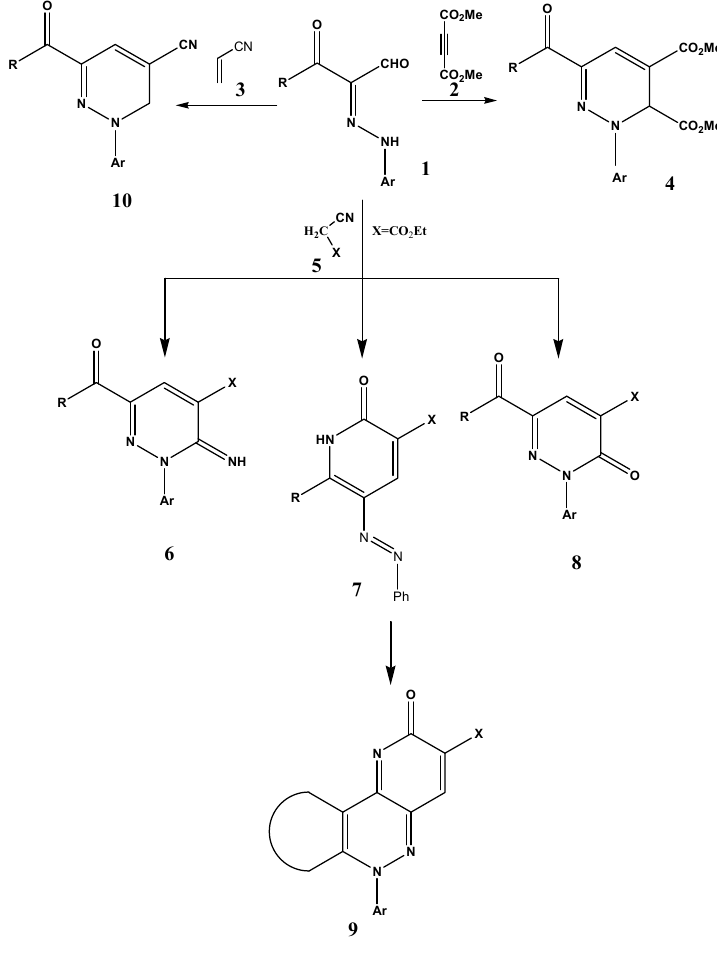
Figure 1. X-ray structure of compound 7